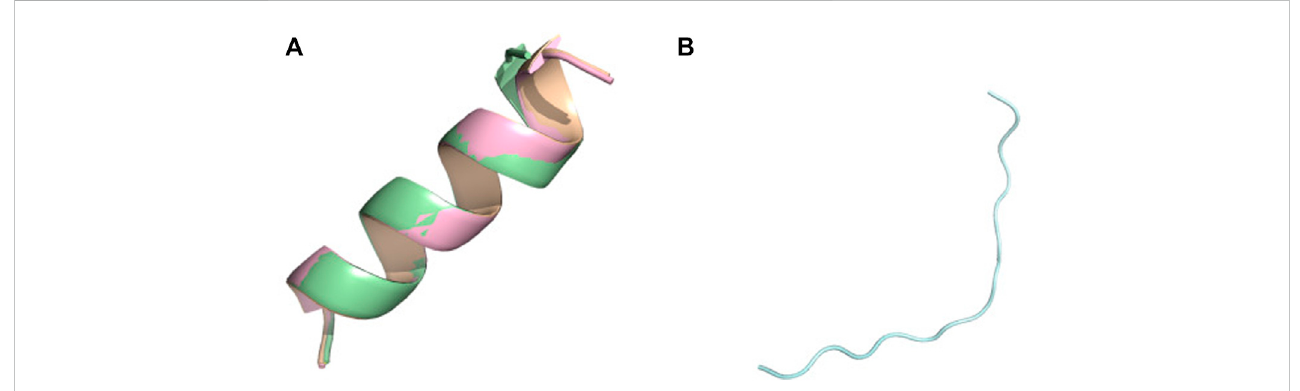
FIGURE 3 Conformational ensemble of (E)15 at pH7.4. (A) PF-noDH, AlphaFold2 and TrRosetta (B) PF-DH. Only the lowest energy (rank 1) model is